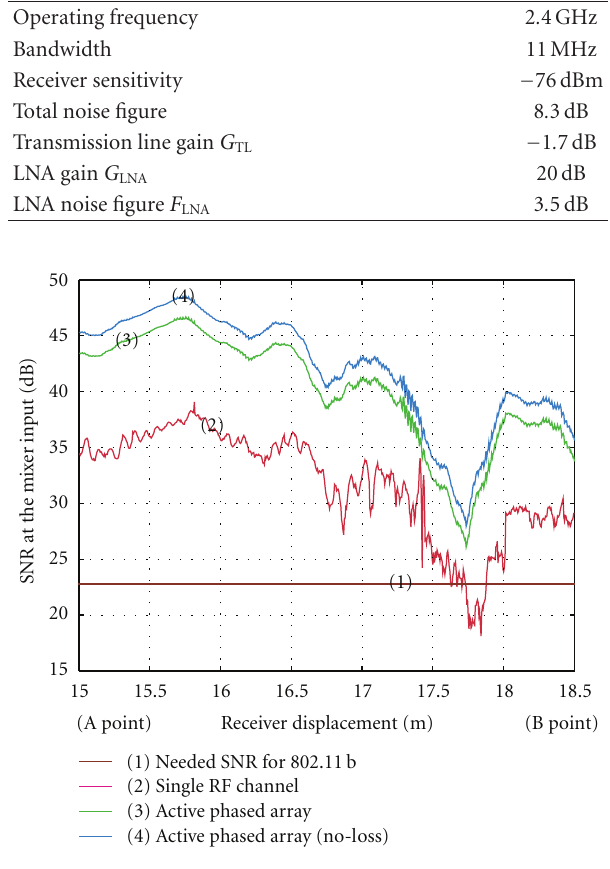
Figure 4: Provided SNR by SAS-MIMO from A to B